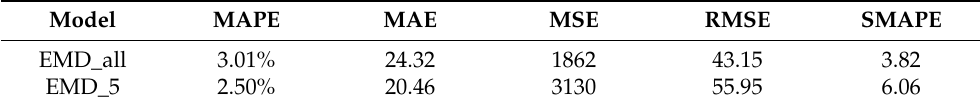
Table 3. Mode decomposition ablation experimental